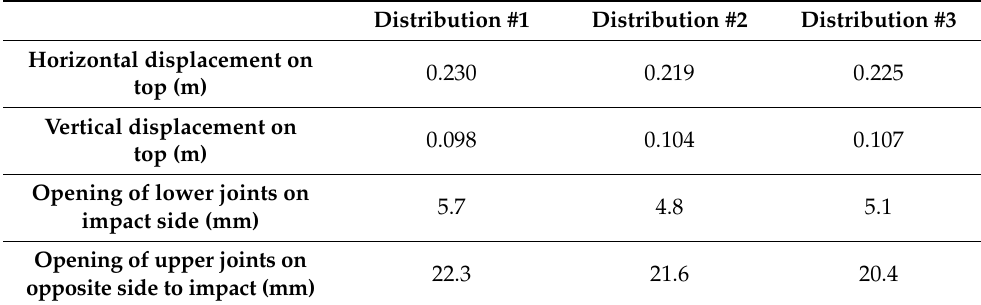
Figure 8. Structural response for the three distributions: ( a ) horizontal displacement; ( b ) vertical displacement.